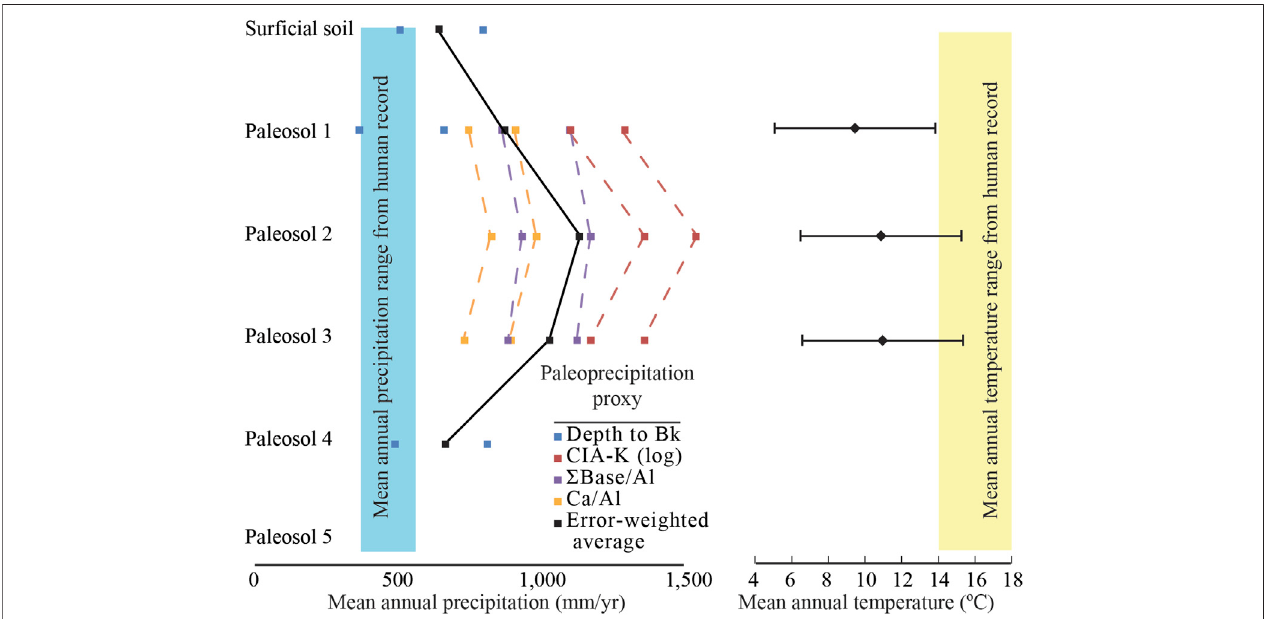
FIGURE 15 | Summarizing MAP (right) and MAT (left) for Paleosols 4-1 and the Sur fi cial Soil. No MAT or MAP were determined for Paleosol 5 due to inadequate data, discussed in text. The modern record of MAP for the SHP, represented by the blue bar, ranges from 310-560 mm/yr (Bomar, 1983). In general, the paleosols appear torecord anincreasinginprecipitationfromPaleosols4-2and adecreasingtrendinprecipitation from Paleosols2-1.Theimplications oftheseMAPcalculations for paleoenvironmental reconstruction are discussed in the text. The modern record of MAT for the SHP, represented by the yellow bar, is 14 ° C and 18 ° C (Bomar, 1983), however the error bars are high, and thus more studies are recommended in order to con fi rm our initial fi